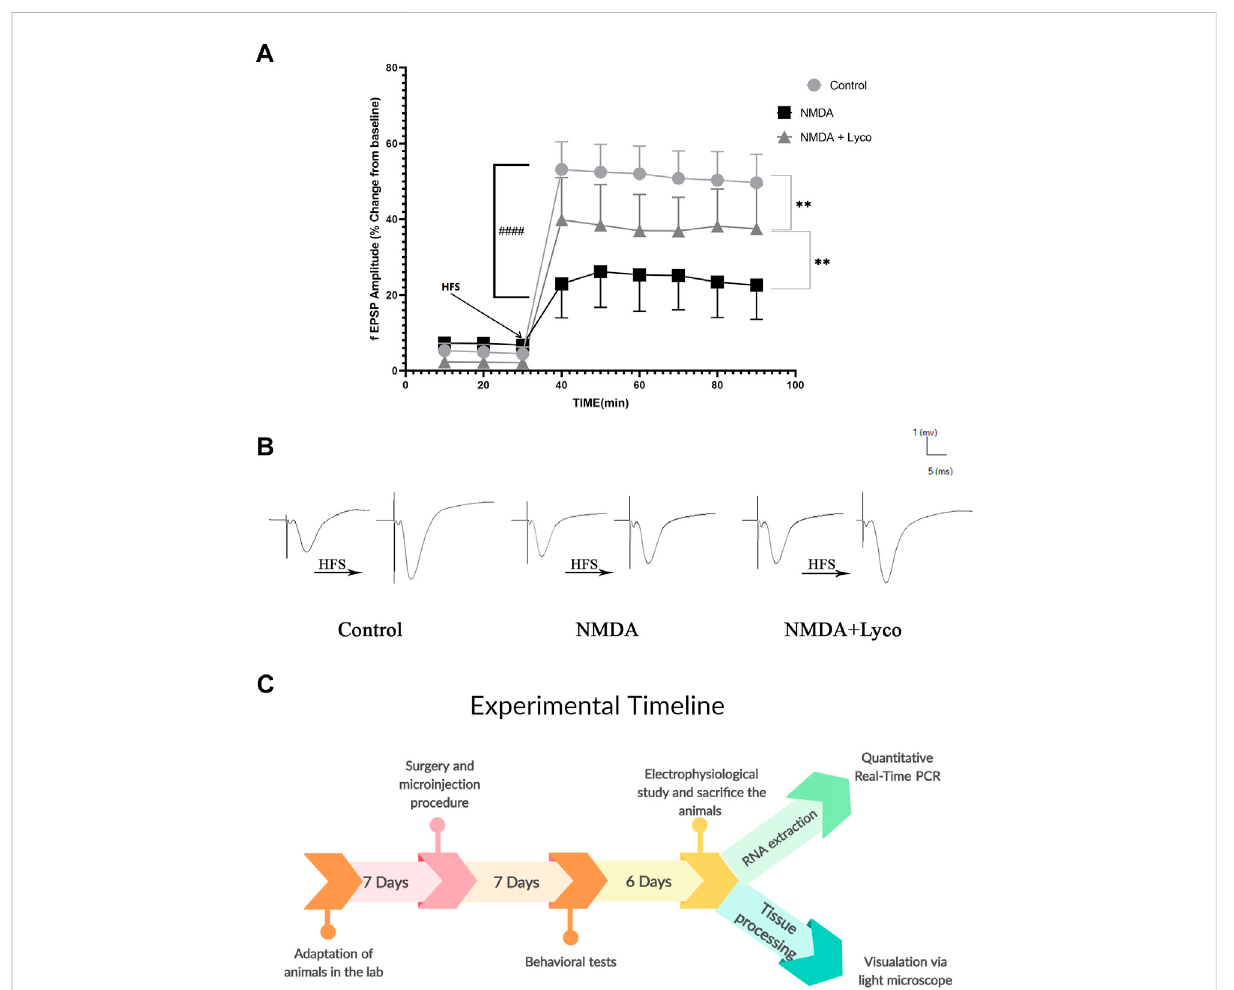
Mossy Fiber circuit LTP (A) Long-term potentiation (LTP) curves of the fi eld excitatory postsynaptic potential (fEPSP) amplitude in the hippocampal CA 3 for the all groups ( n = 6). The data are shown as means ± SEM of six rats per group. (* p < 0.05 and ** p < 0.01 and *** p < 0.001 and **** p < 0.0001),and( #### p < 0.0001). (B) SampletracesoftypicalrecordedfEPSPsinthehippocampalCA3neuronsbeforeandafterhigh-frequency stimulation (HFS) induction for the long-term potentiation (LTP) in experimental groups. (C) Experimental timeline. Timeline showing the sequence of events and behavioral testing the animals